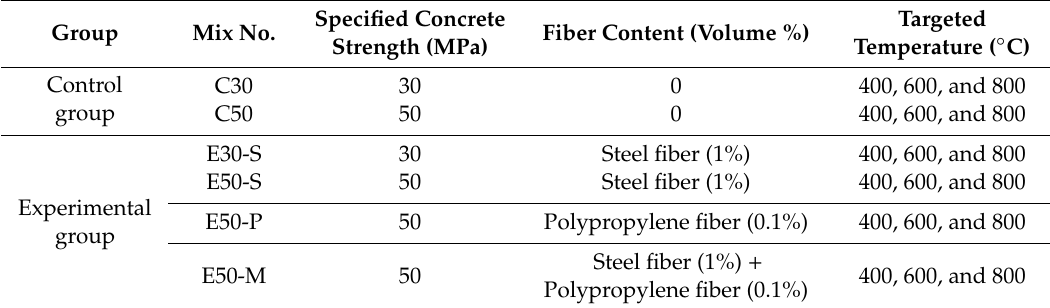
Table 1. Planning of experimental variables.